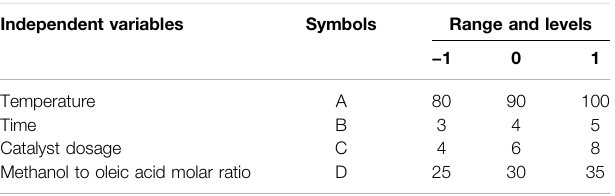
TABLE 1 | Experimental parameters and range of response surface methodology optimization. Independent variables